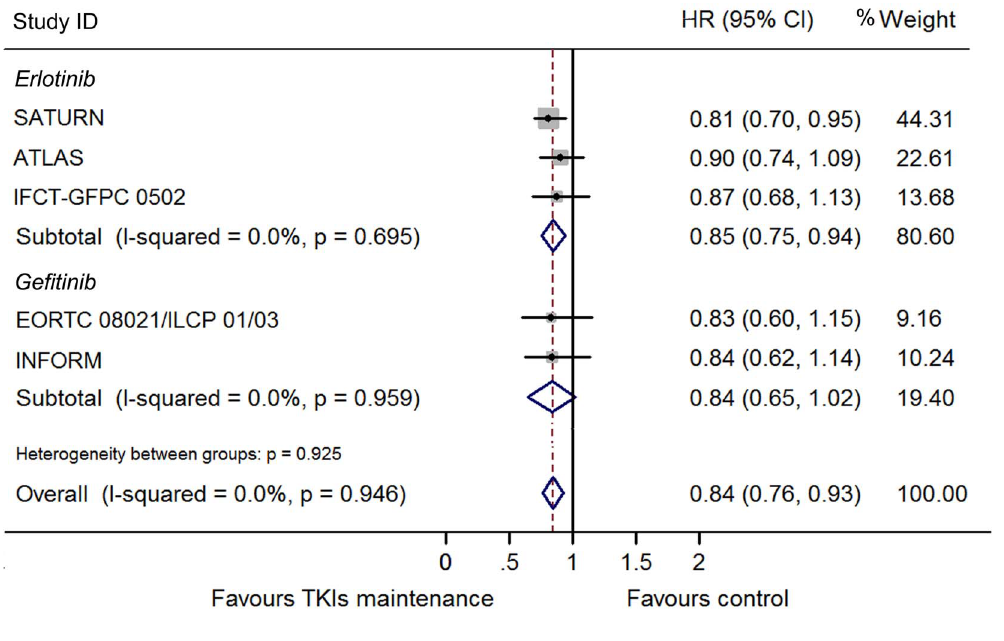
Figure 4. Meta-analysis of hazard ratio (HR) for overall survival (OS).